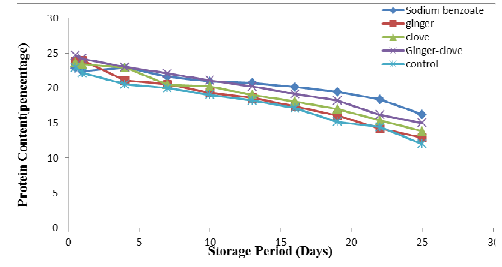
Fig. 10. Effects of different treatments on protein content of soymilk samples at 1% concentration stored at refrigerated temperature for 25 days